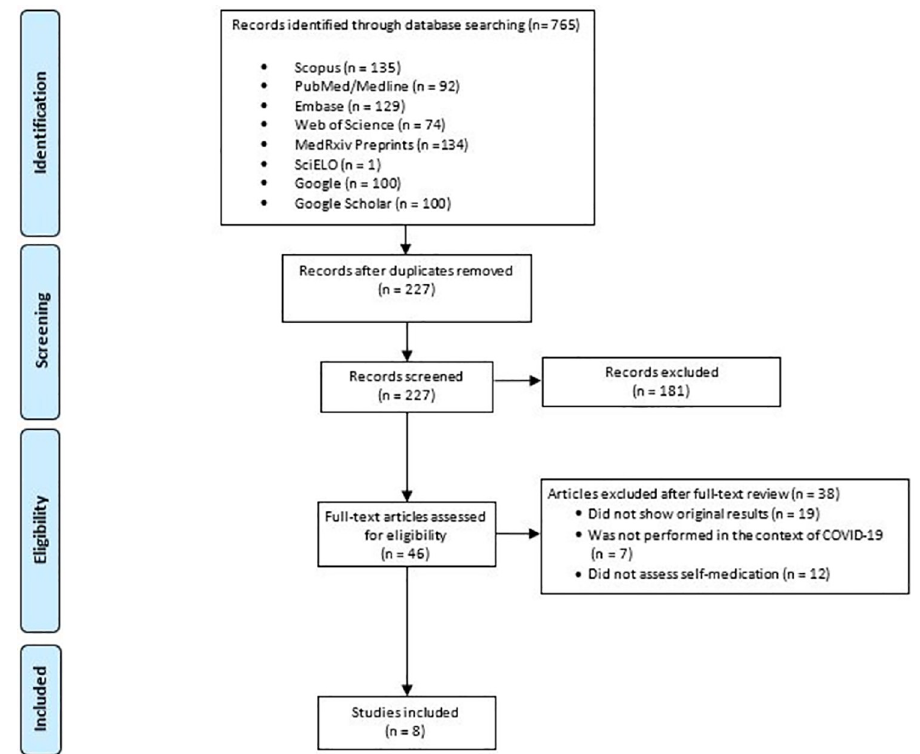
Fig 1. Flow diagram of study